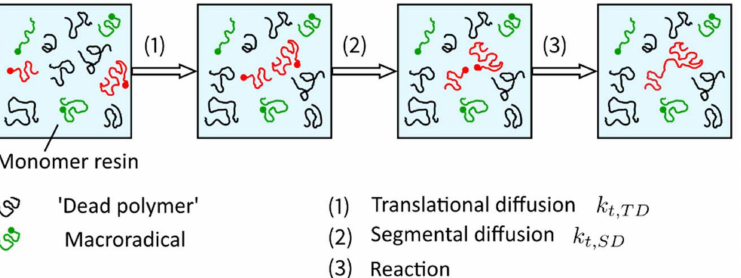
Figure 17. Scheme of bimolecular termination reactions between two macroradicals (colored in red). Two polymer coils must come into contact by center-of-mass translational diffusion (1), and segmental reorientation (segmental diffusion) (2) has to occur in order to bring both reactive chains ends in proximity and to form a radical-radical encounter pair (3).